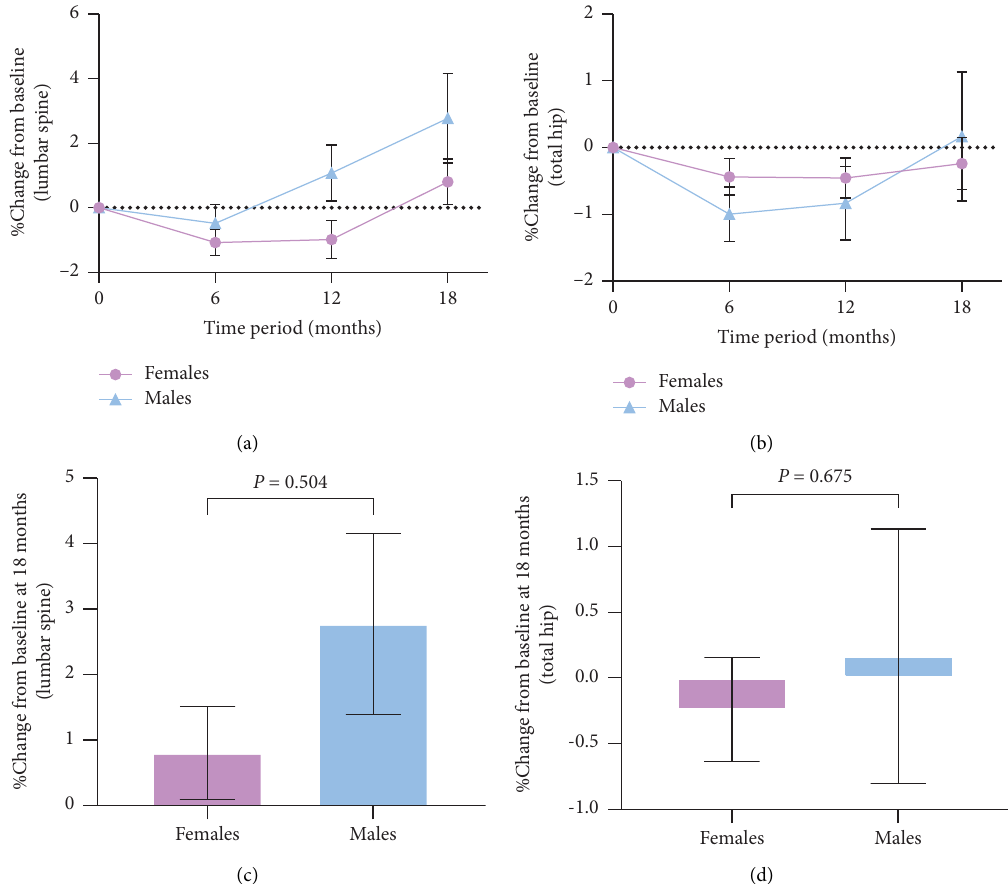
Figure 3: Diferences between sexes in percentage change in BMD. (a) Changes in lumbar spine BMD over an 18-month treatment period; (b) changes in total hip BMD over an 18-month treatment period; (c) diference in change between sexes in lumbar spine BMD at the 18 th month; (d) diference in change between sexes in total hip BMD at the 18 th month. Te results are presented as the mean ± SE. P values are not signifcant (Mann–Whitney U